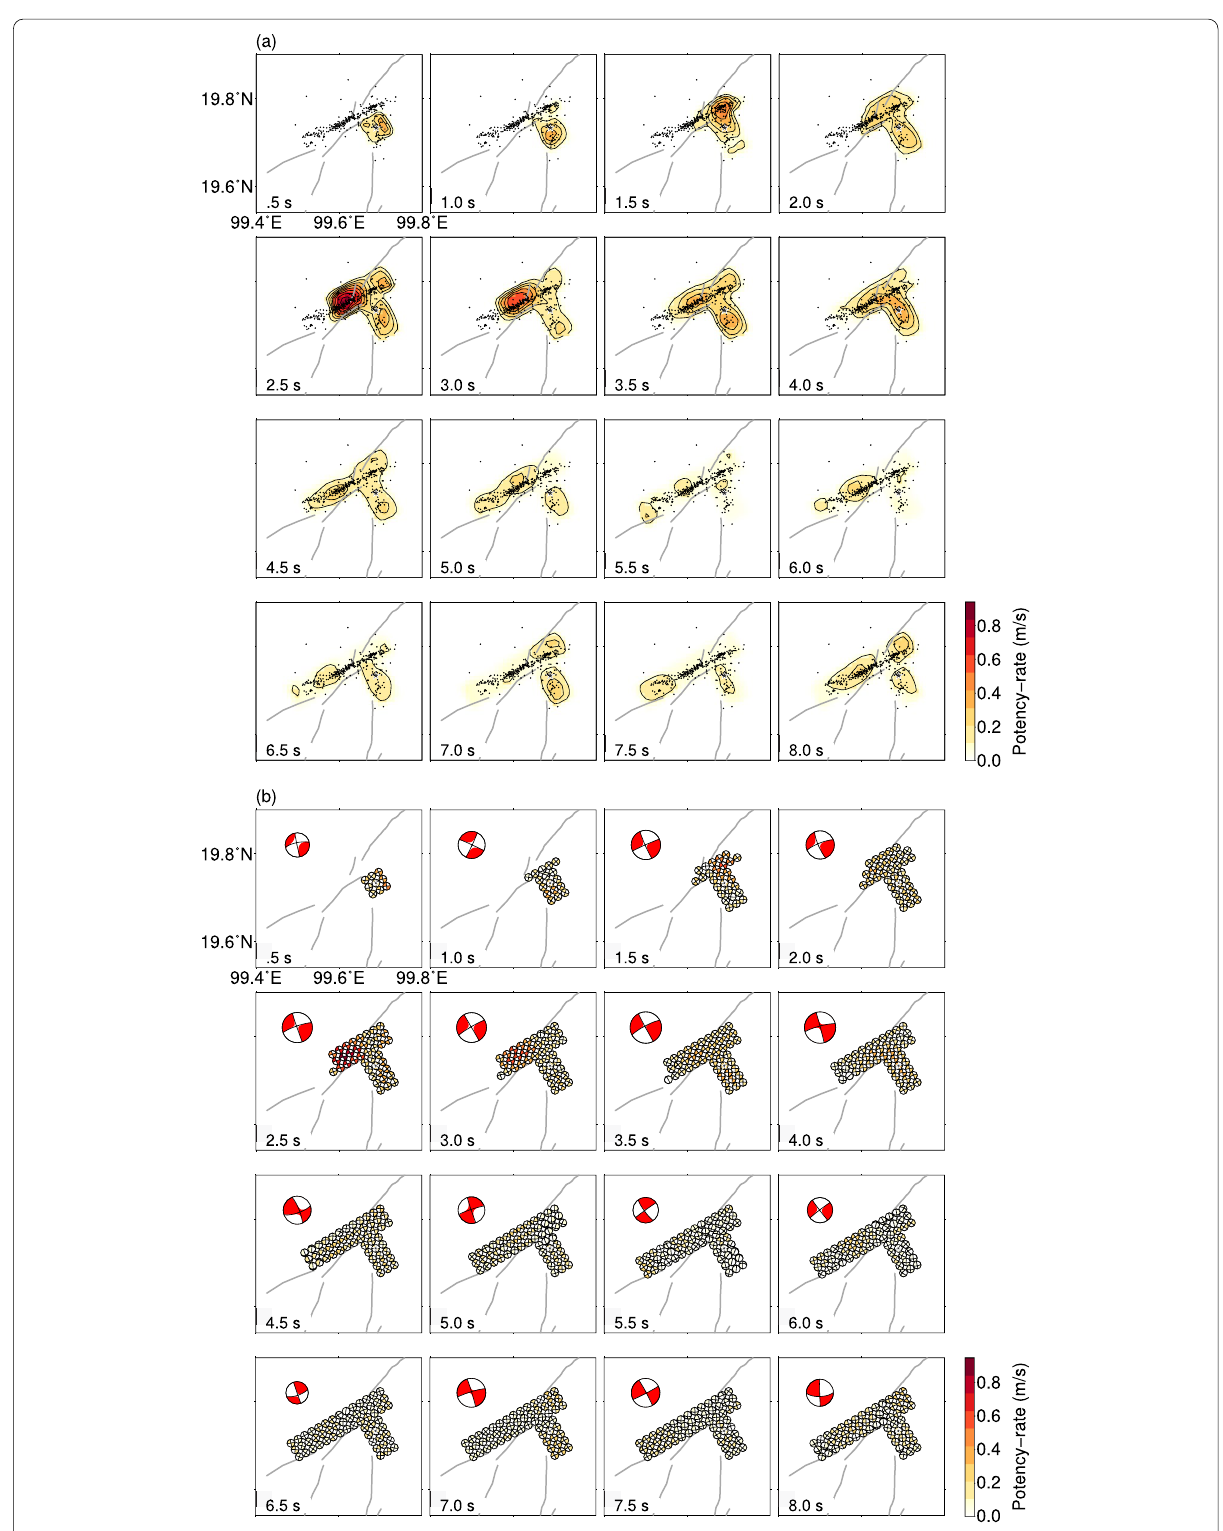
Fig. 8 The spatiotemporal distribution of the a potency-rate density and the b focal mechanism distribution of the potency-rate density tensor in each time window. The red beach ball shows the total moment tensor solution within the time window. The star shows the epicenter. The dots show the relocated aftershock (Pananont et al. 2017). The line shows the active faults (DMR 2016; Kanthiya et al.